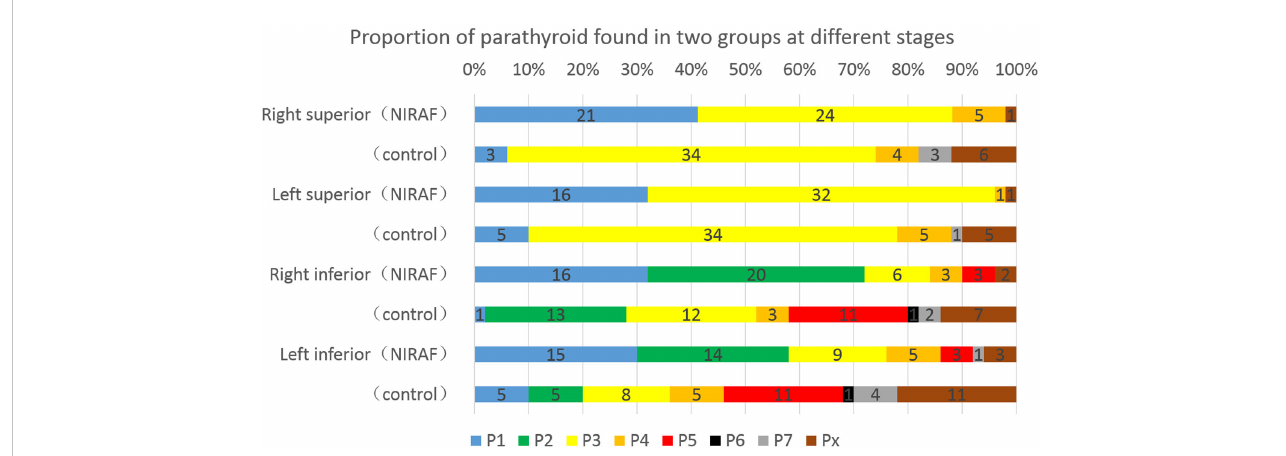
FIGURE 7 Different stages of parathyroid gland discovery in the NIRAF group and control group. Blue and green bars were basically safe phases, and the blood supply vessels in the parathyroid glands remained intact. Yellow and brownish yellow bars were the last stages of gland disconnection, and the blood supply vessels might be at risk. The red bars indicate that the blood supply to the parathyroid gland was at a critical stage during lymph node dissection. Black and gray bars indicate that the parathyroid gland had been isolated or identi fi ed in paraf fi n pathology. The brown bars indicate that the parathyroid gland was not located.